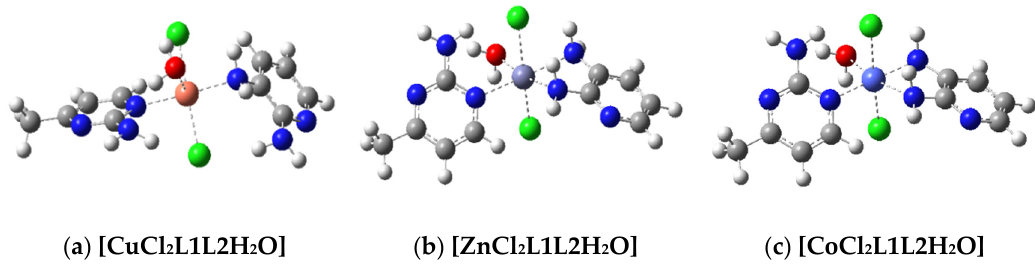
Figure 5. Optimized geometry of the complexes. ( a ) Cu(II) ( b ) Zn(II), and ( c ) Co(II).